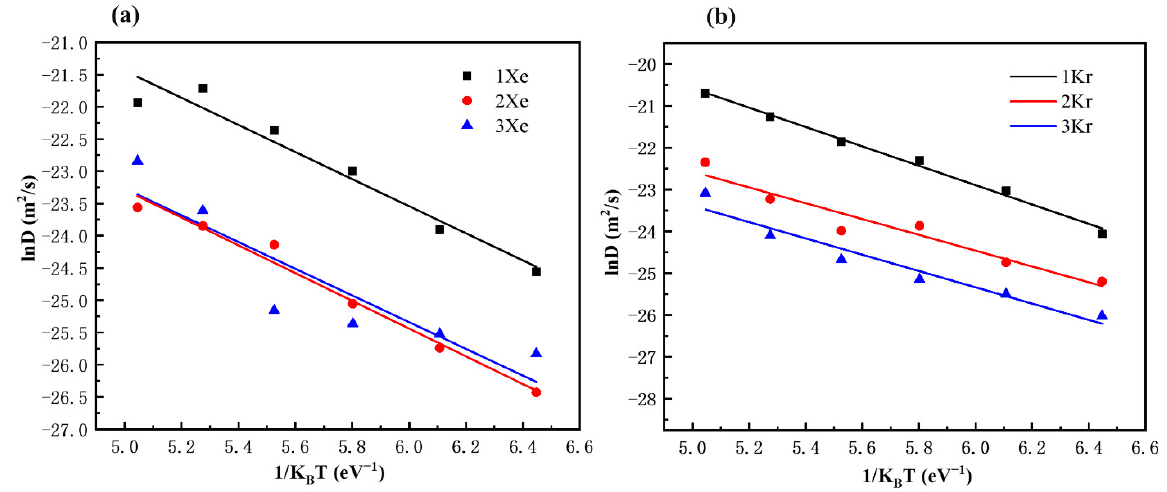
Figure 4. The diffusion coefficient for ( a ) Xe and ( b ) Kr clusters in bulk UO 2 . The lines are linear Arrhenius fits.